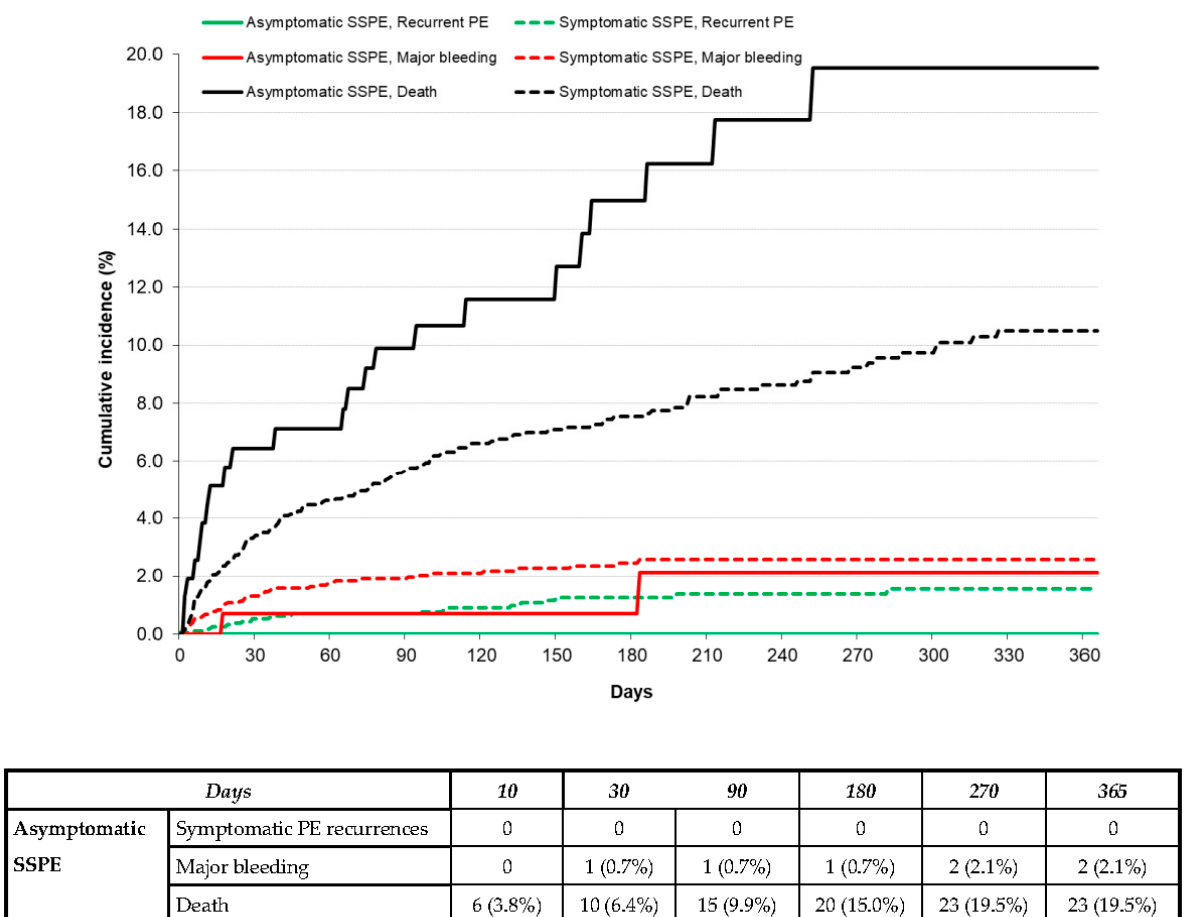
Figure 1. Cumulative incidence rate of symptomatic PE recurrences, major bleeding, or death during the course of anticoagulation in patients with asymptomatic vs. symptomatic SSPE. After discontinuing anticoagulant therapy, 28 patients developed symptomatic PE recurrences, 13 had lower-limb DVT, 6 had major bleeding, and 75 died (fatal PE 1 and fatal bleeding 5). The patients with asymptomatic SSPE had a similar rate of PE recur- rences (HR: 1.27; 95% CI: 0.20–4.55) and a non-significantly higher mortality rate (HR: 2.06; 95% CI: 0.92–4.10) to those with symptomatic SSPE (Table 3 and Figure 2). No patient with asymptomatic SSPE developed DVT or major bleeding after discontinuing anticoag- ulation (Table 3).